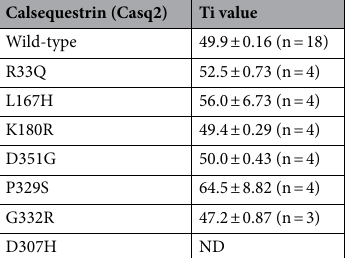
Table 2. Ti values for Casq2 and Casq2